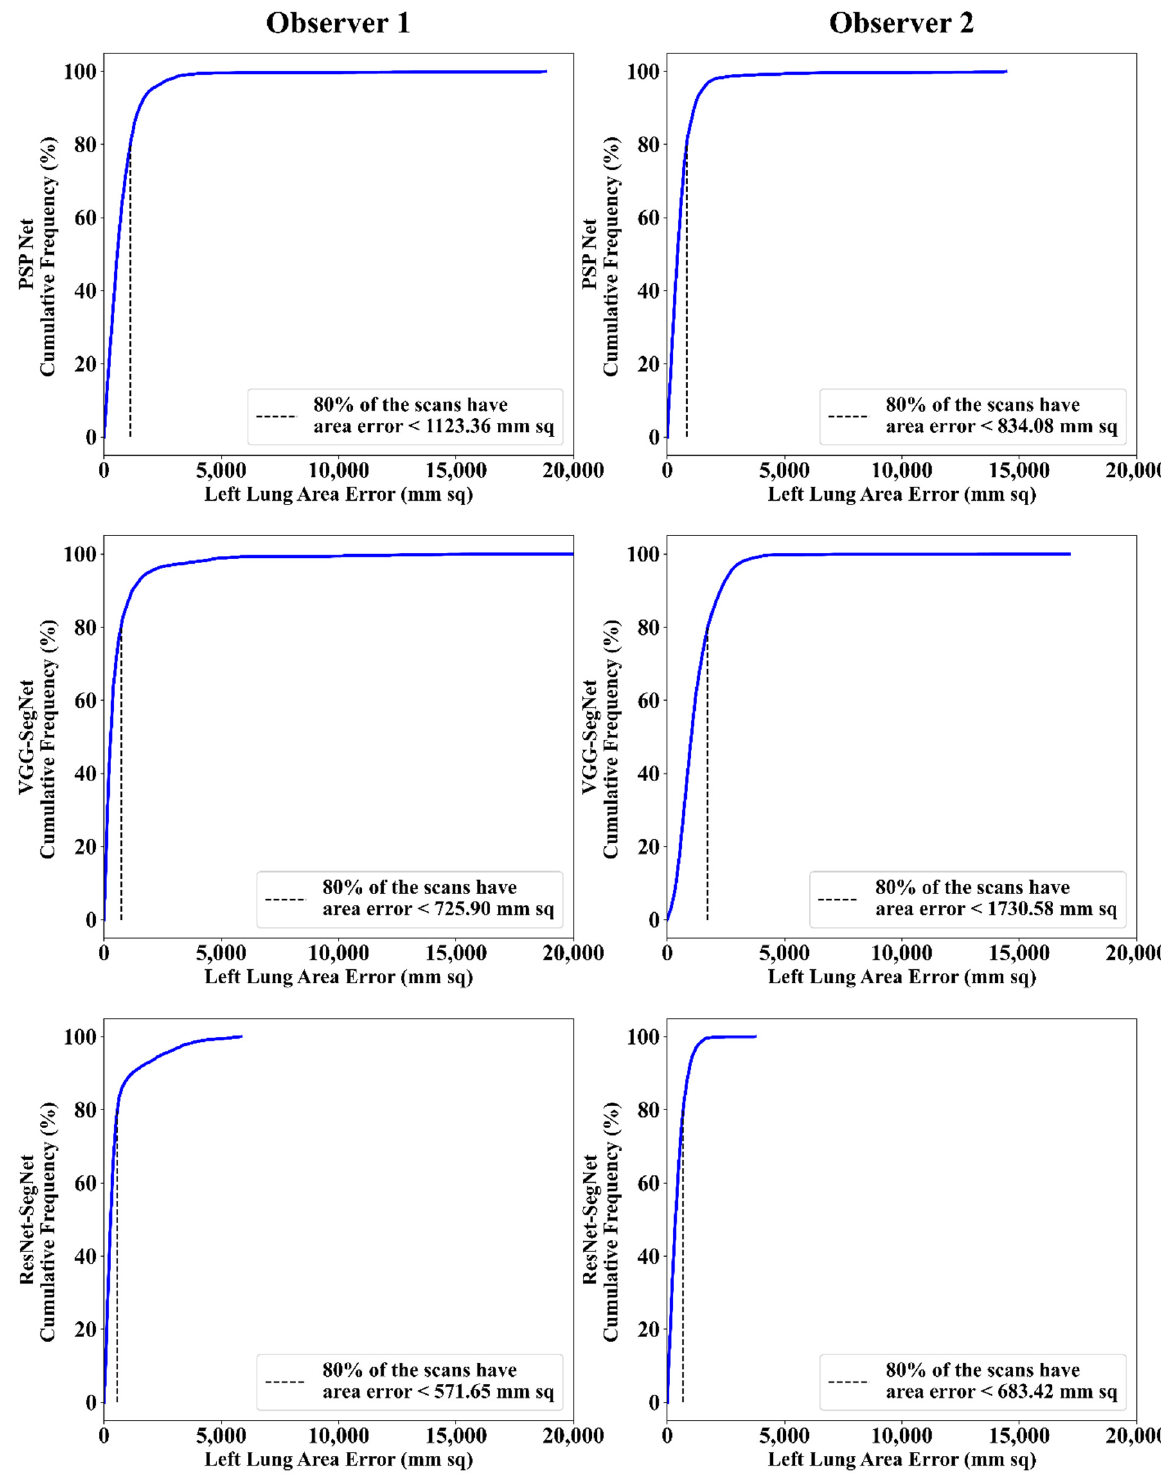
Figure 12. Cumulative frequency plot of left LAE using three AI models: Observer 1 vs. Observer 2.